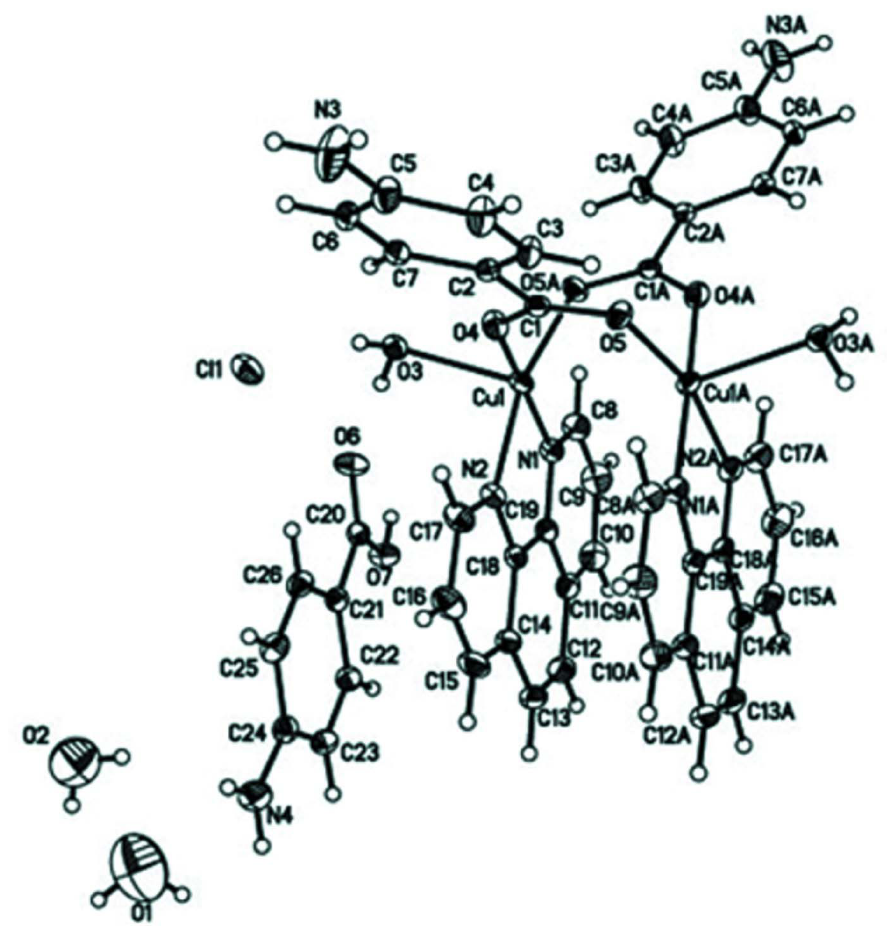
The ORTEP - 3 (Farrugia, 1997) drawing of the title compound. Displacement ellipsoids are drawn at 30% probability level. Symmetry code for letter "A" in the atomic symbols: -x, y,